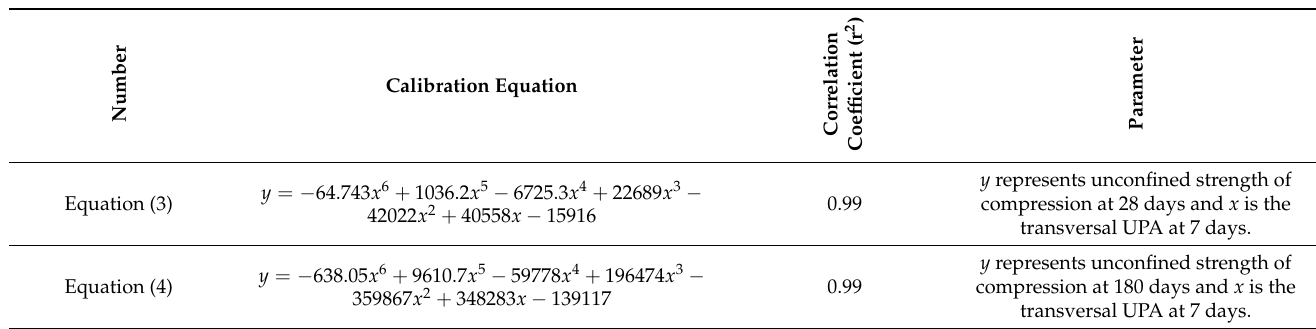
Table 4. Calibration equations for predicting unconfined strength of compression strength from transversal UPA.